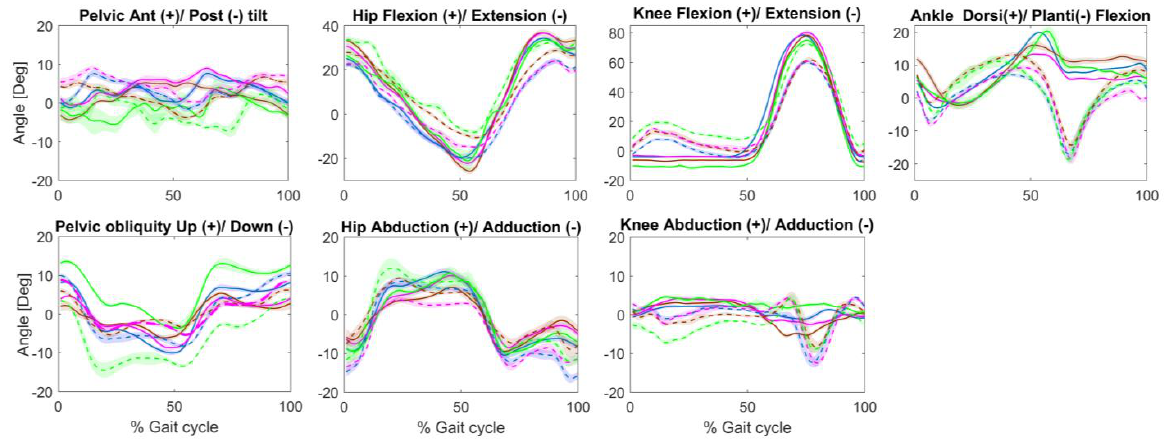
Figure 2. Joint angles in the sagittal and frontal plane during walking in four prostheses conditions: Variflex (blue), Meridium (brown), Echelon (magenta), and Kinterra (green). The kinematic of the amputated leg is presented in a continuous line, and that of the unaffected leg is presented in a dotted line. The shaded region denotes the standard deviation.